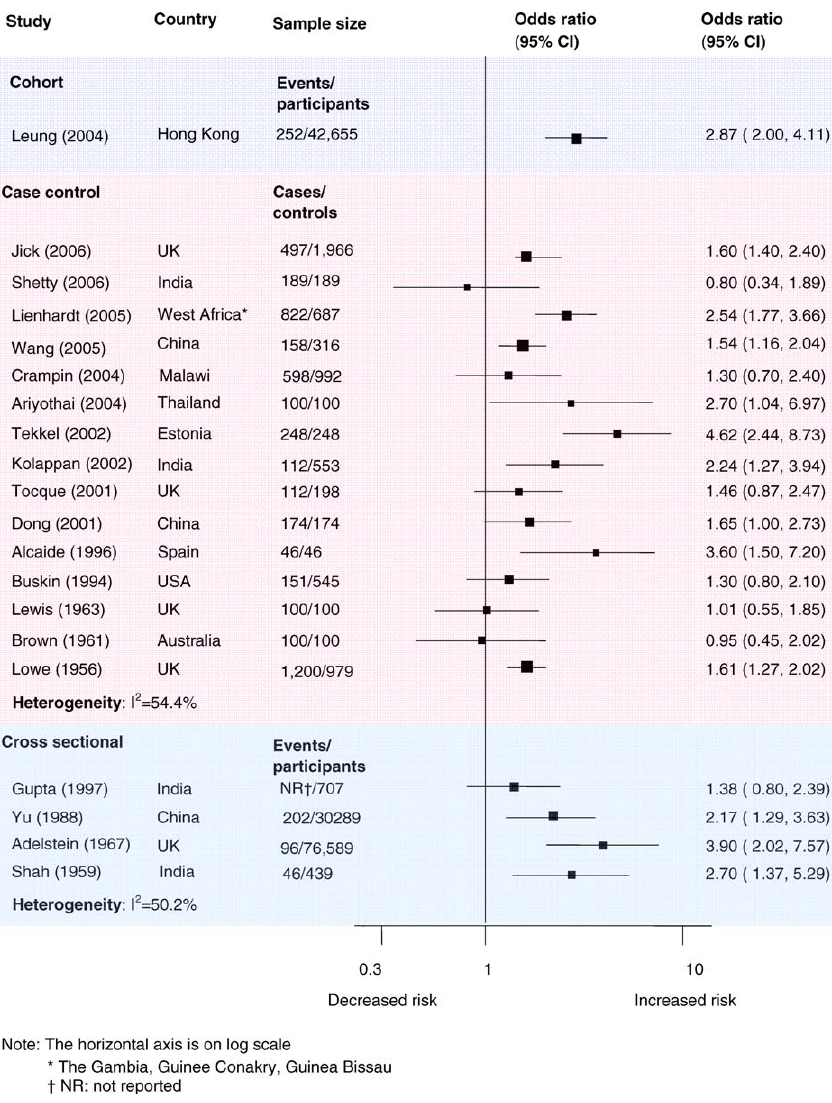
Figure 3. Risk of Clinical TB Disease for Current Smoking Compared with